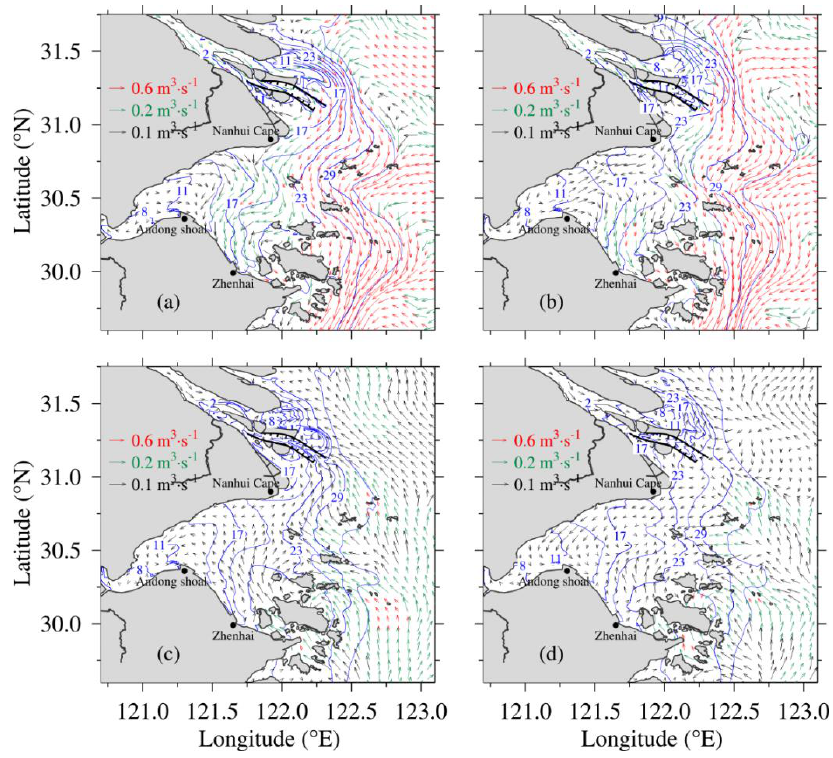
Figure 9. Distribution of the RUWF and salinity in the surface layer (upper panel) and bottom layer (lower panel) during neap tide ( a , c ) and spring tide ( b , d ) in winter. The distribution of RUWF in the whole layer during the spring and neap tides in the summer and winter is shown in Figure 10. In the summer, the water from the Changjiang Estuary is mainly transported from the north channel into the sea, and then, it flows north- east-northward in the neap tide and northward and southward in the spring tide. In Hangzhou Bay, the RUWF flows northward at the mouth and has a cyclonic eddy north of Zhenhai, and it flows westward along the north coast and eastward along the south coast with small values in the middle and western parts of the bay during the neap tide. More water from the Changjiang Estuary is transported into Hangzhou Bay during the spring tide, and it flows westward along the north coast; then, it flows eastward along the south coast, forming a distinct horizontal circulation that is “ north-landward and south- seaward ” in the bay. In the winter, the water from the Changjiang Estuary is transported southward under the force of the northerly wind, and a small part flows into Hangzhou Bay. In Hangzhou Bay, the RUWF is weak and still has a cyclonic eddy north of Zhenhai in the neap tide, and during the spring tide, the pattern is very similar to that in the sum- mer, only the magnitude is slightly smaller.